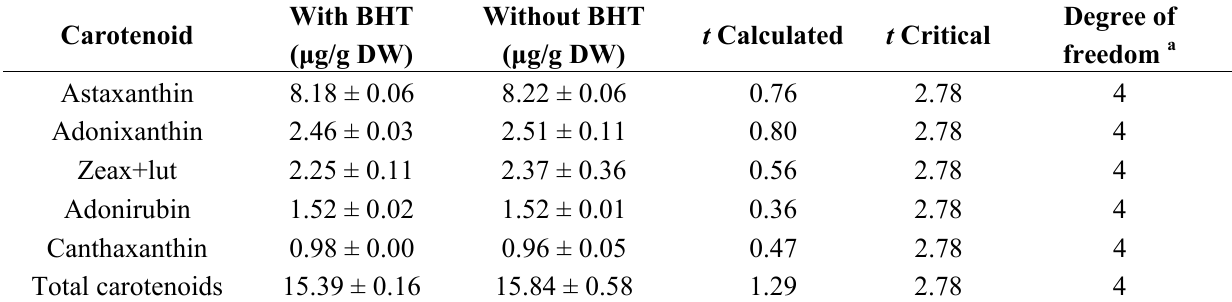
Table 2. Comparison of the individual and total carotenoid content of samples extracted with and without